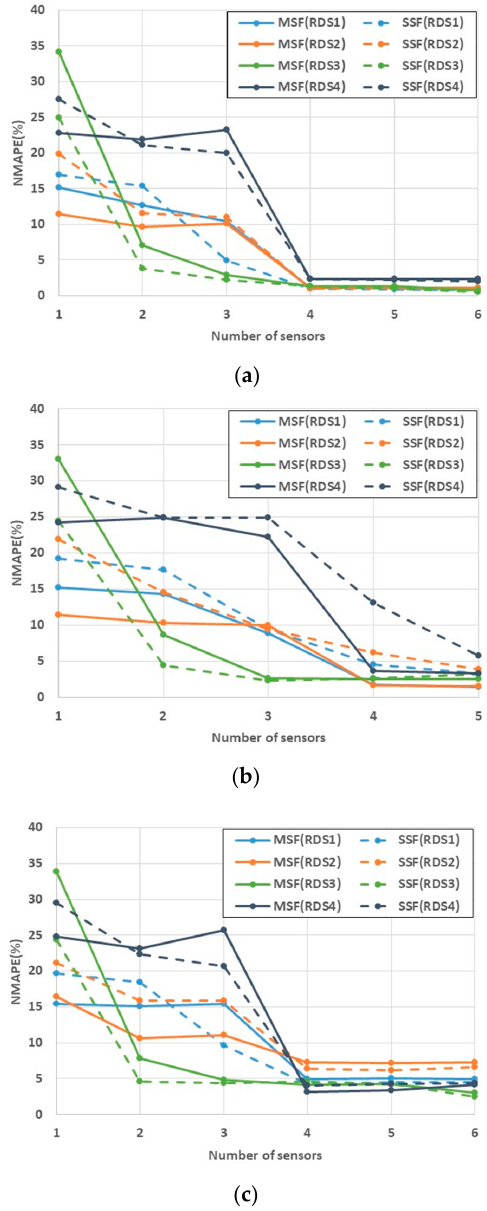
Figure 9. Normalized mean absolute percent error (NMAPE) by MSF and SSF according to the number of sensors: ( a ) displacement, ( b ) slope, ( c ) strain.